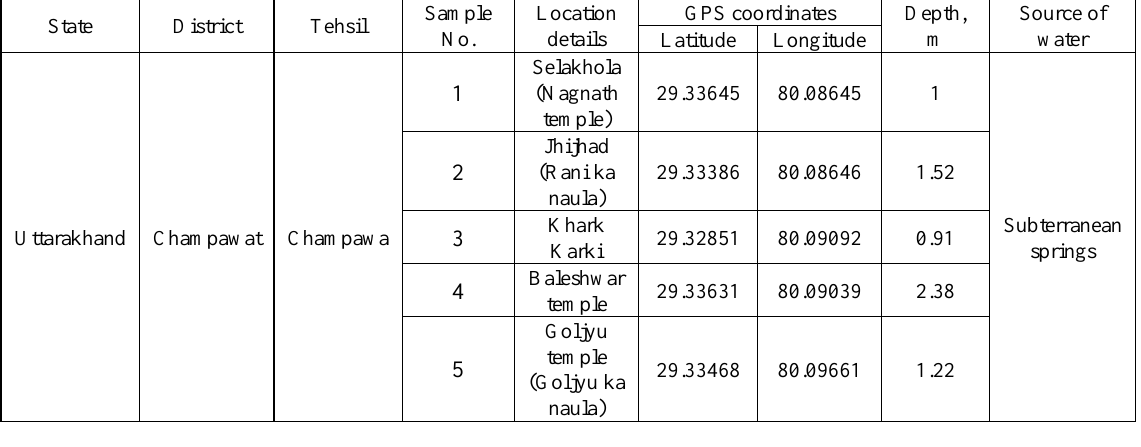
Table 1. Location details with their corresponding GPS coordinates